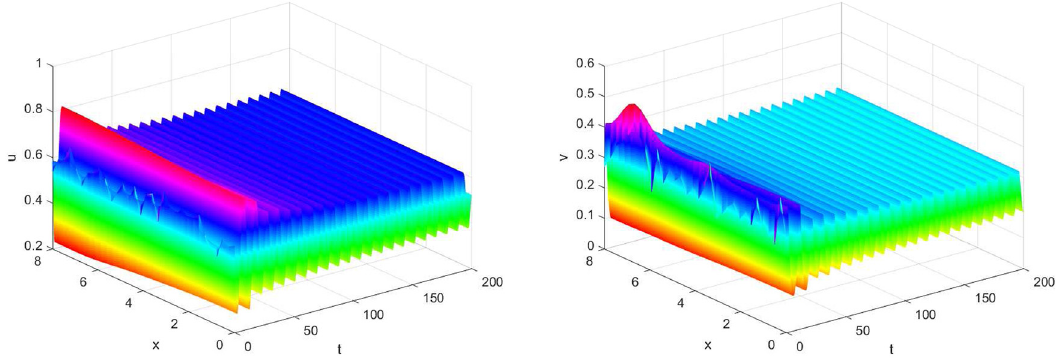
Figure 7: Phase portraits of ( 1.5 ) with parameters = = = = a σ d d 4.1, 1, 2, 0.2 1 2 . Bifurcated homogeneous periodic solution is stable.